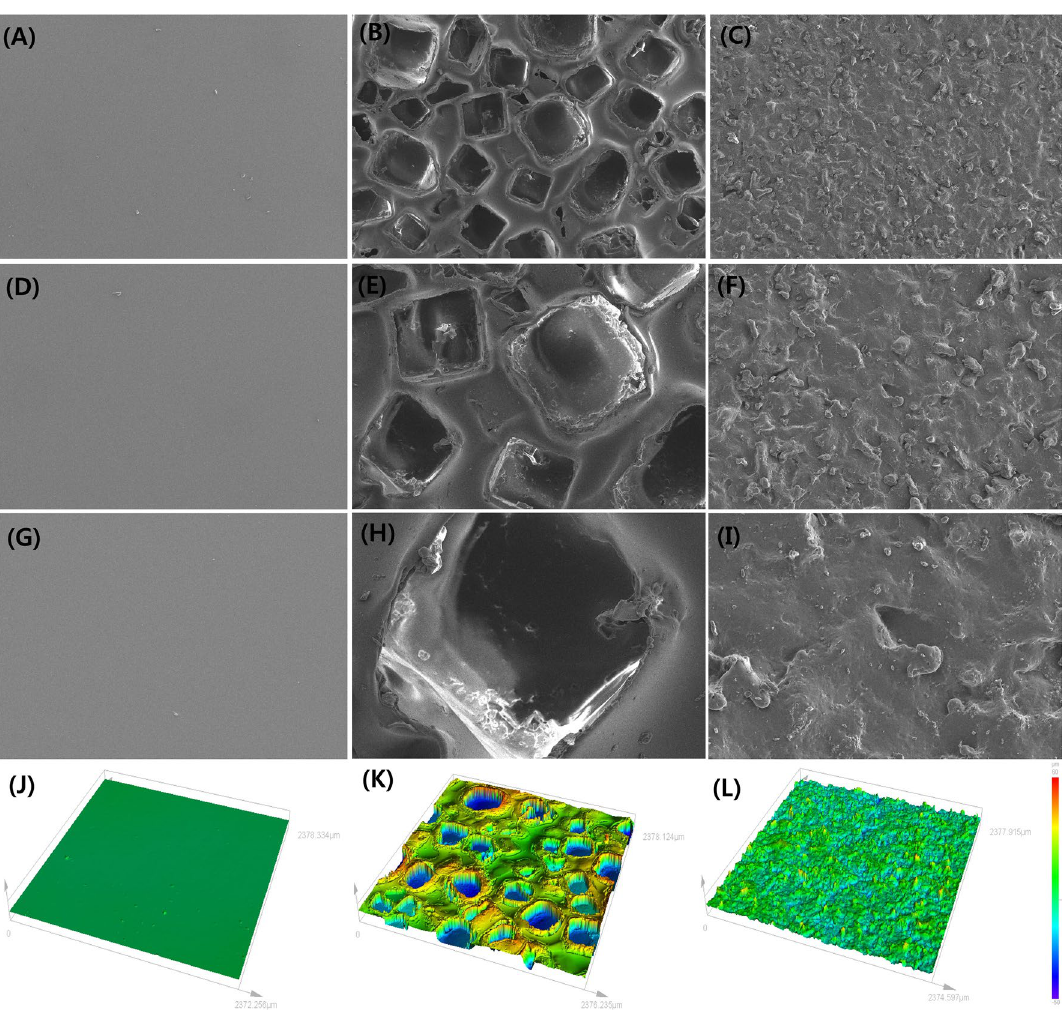
Figure 1. Implant surface topography measured by scanning electron microscopy and 3D confocal laser scanning microscopy. Scanning electron microscopy images of the three types of implants with different topographies. ( A ) smooth type (top view × 50) ( B ) macrotexture type (top view × 50), ( C ) nanotexture type (top view × 50), ( D ) smooth type (top view × 100), ( E ) macrotexture type (top view × 100), ( F ) nanotexture type (top view × 100), ( G ) smooth type (top view × 300), ( H ) macrotexture type (top view × 300), ( I ) nanotexture type (top view × 300). 3D confocal laser scanning microscope images of three types of implants with different topographies. The roughness was measured to be 0.53 ± 0.14, 104.82 ± 7.49, and 6.53 ± 0.25 µm in the smooth, macrotexture, and nanotexture type implants, respectively: ( J ) smooth type, ( K ) macrotexture type and ( L